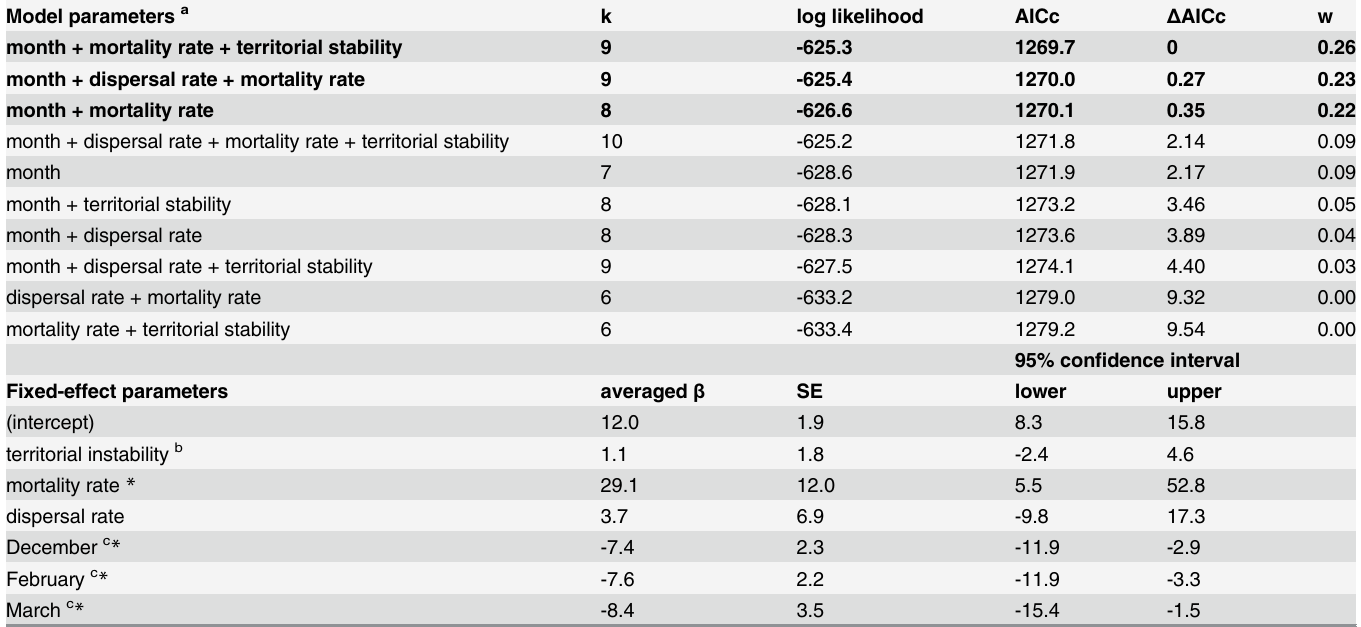
Table 5. Results of selection and averaged fixed-effects coefficients of mixed-models exploring the effect of territorial stability, mortality rate, dis- persal rate, and month on fecal cortisol metabolites levels in three wolf packs from Yellowstone National Park (USA), 2007 – 2009. Only candidate models with Δ AICc < 10 are shown. We used candidate models with Δ AICc < 2 (bold face) for model coefficient